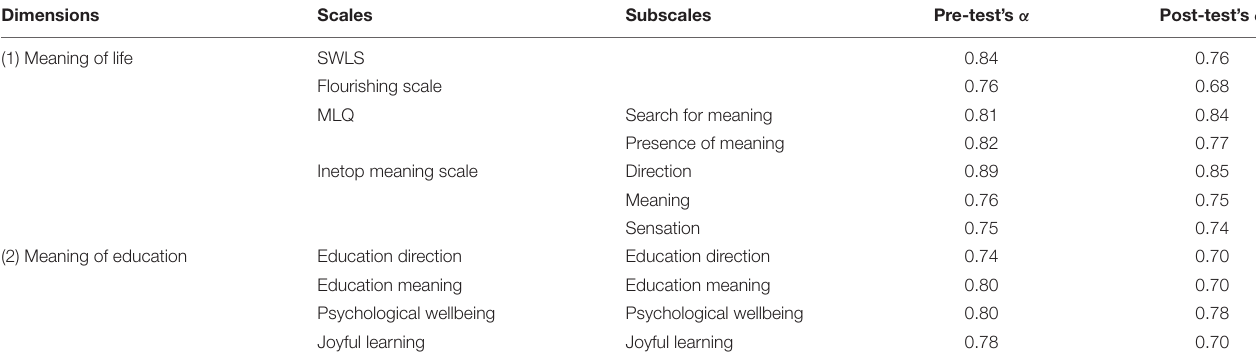
TABLE 1 | Pre- and post-test SVSF measurement instrument ( N = 43).